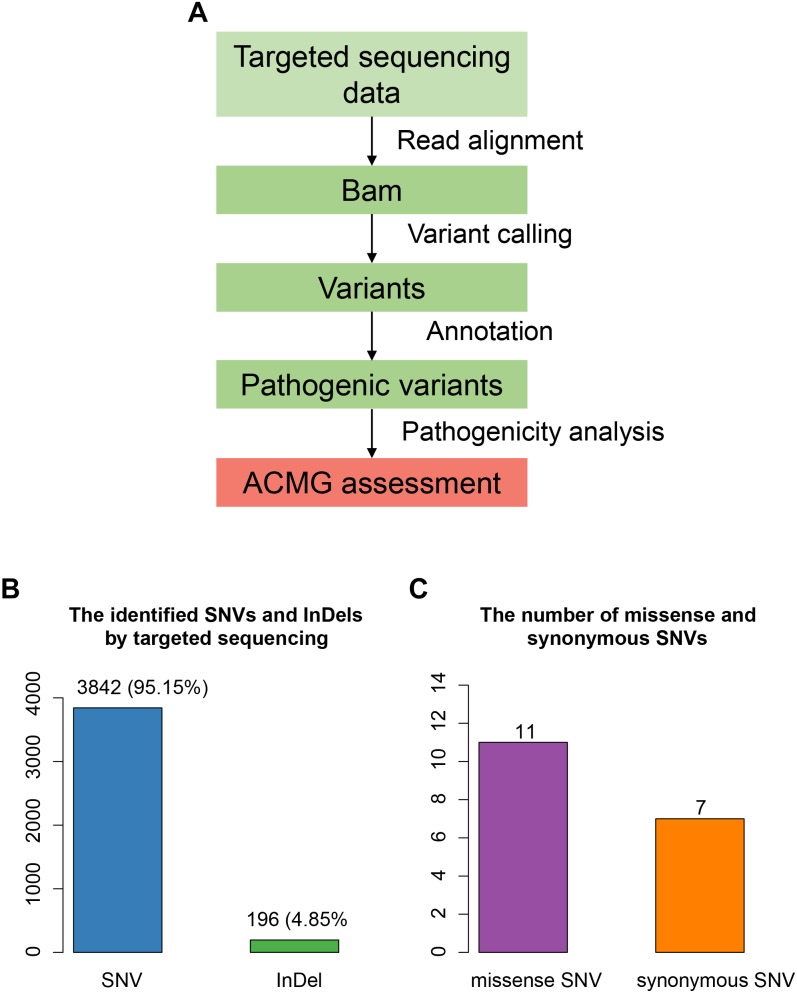
Targeted sequencing-based identification of pathogenic variants. (A) Workflow for the analysis of targeted sequencing data. (B) The SNVs and InDels identified by targeted sequencing. (C) The number of missense and synonymous SNVs in coding regions.